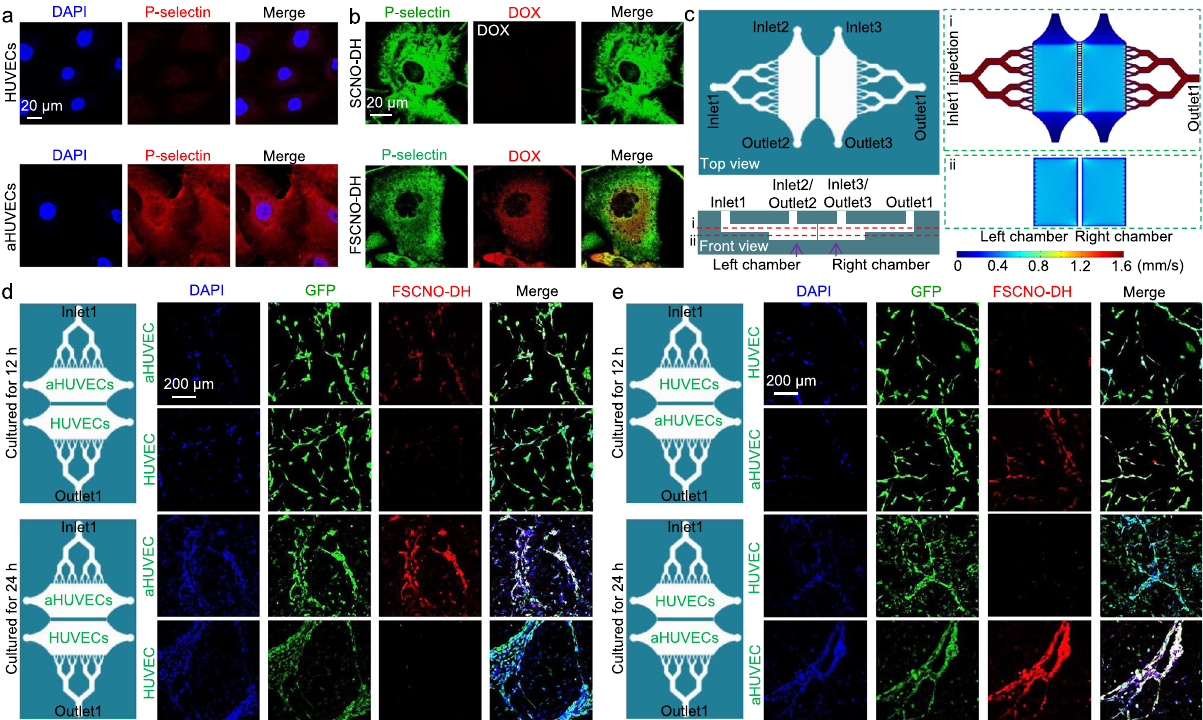
Fig. 5 P-selectin targeting capability of the FSCNO nanoparticles under both static and dynamic/micro fl uidic cultures. a Confocal images showing the expression of P-selectin in activated human umbilical vein endothelial cells (aHUVECs) but not in HUVECs without activation. b Confocal images of precooled aHUVECs after incubated with SCNO-DH and FSCNO-DH nanoparticles (10 μ g ml − 1 for DOX and 5 μ g ml − 1 for HM). The cells were precooled in ice for 3 h to stop its metabolic and uptake activity. c Top and side views of the micro fl uidic device for studying the P-selectin targeting capability of the FSCNO-DH nanoparticles under dynamic culture condition. Detached cells can be injected into device through inlet2 or inlet3 and cultured in the chambers. Medium containing nanoparticles can be injected through inlet1 and fl ows out the device via outlet1. Also shown are the computational modeling results of velocity distribution at the middle planes of the channels and chambers, in the top and bottom PDMS parts as indicated by the red dashed lines i and ii, respectively. The data show that the velocity of injected nanoparticle solution (inlet1) is nearly homogeneous in the two chambers. d, e Scheme and confocal images of green fl uorescence protein (GFP)-expression HUVECs (in the chamber next to outlet1 for d and in the chamber next to inlet1 for e ) and aHUVECs (in the chamber next to inlet1 for d and in the chamber next to outlet1 for e ) cultured in the micro fl uidic device for 12 and 24 h after binding with FSCNO-DH nanoparticles in the perfusion medium for 3 h. The data indicate that the FSCNO-DH nanoparticles can target the aHUVECs ef fi ciently regardless of the culture conditions (i.e., static versus dynamic, and for the latter: close or away from the